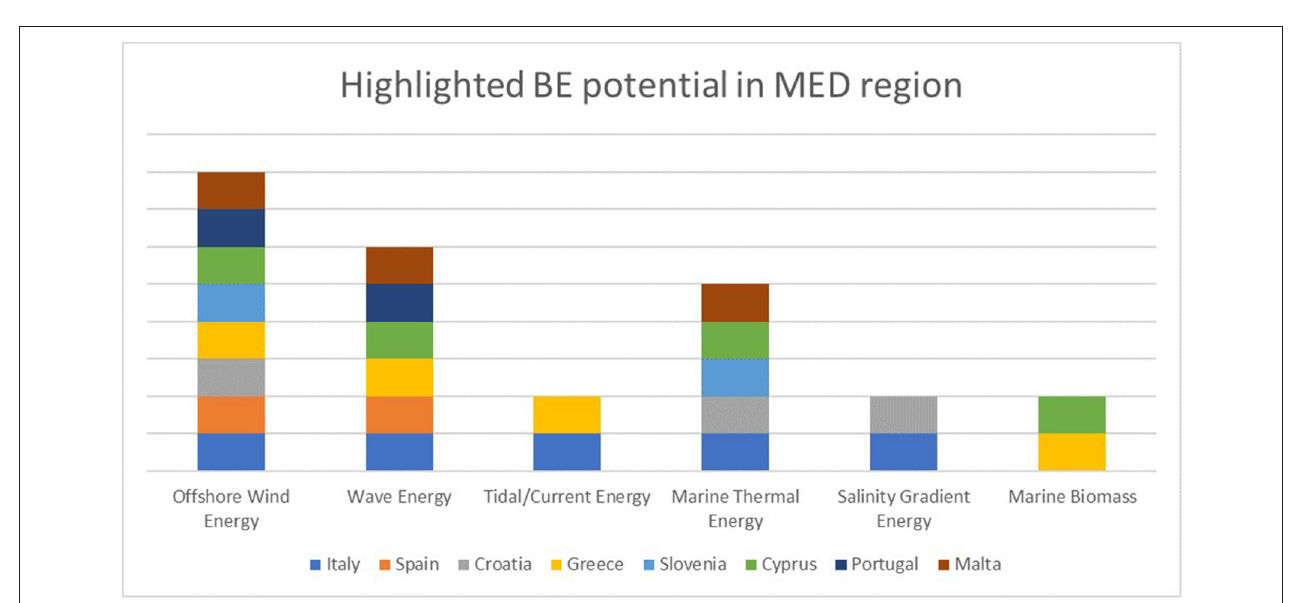
FIGURE 1 | Highlighted BE forms by each country of study. Marine thermal energy is used directly for heating and cooling rather than for electricity production.